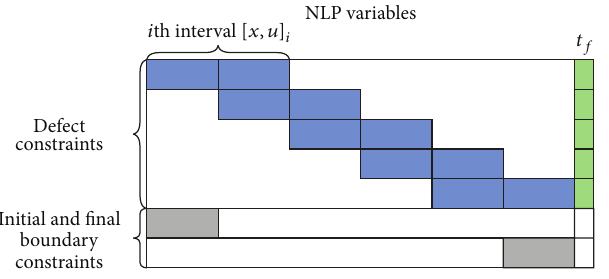
Figure4:Jacobian structureforthird-orderGauss-Lobattomethod.